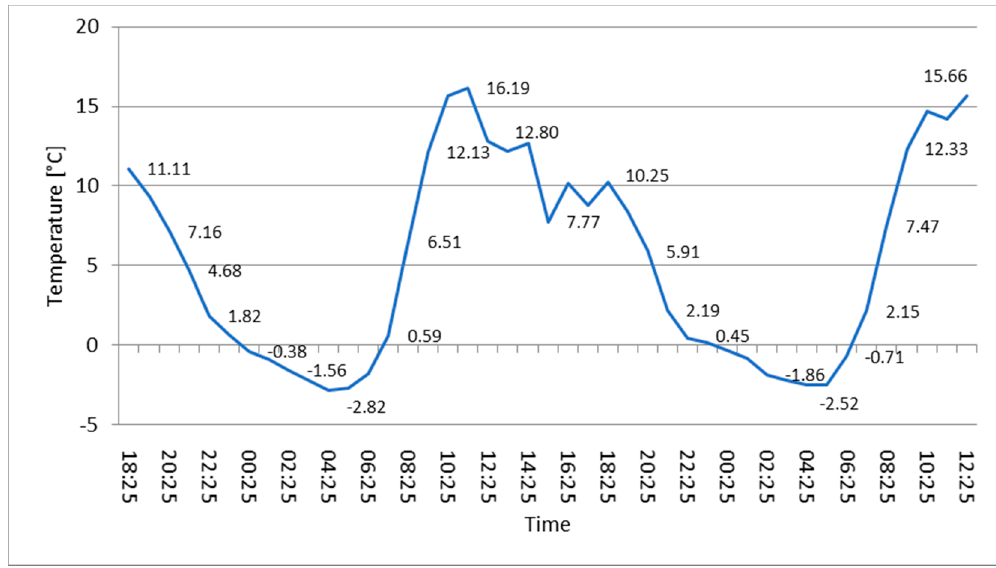
Figure 1. Air temperature fluctuations measured at 1.5 m height from 3 to 5 May 2011. Agronomy 2020 , 10 , x FOR PEER REVIEW